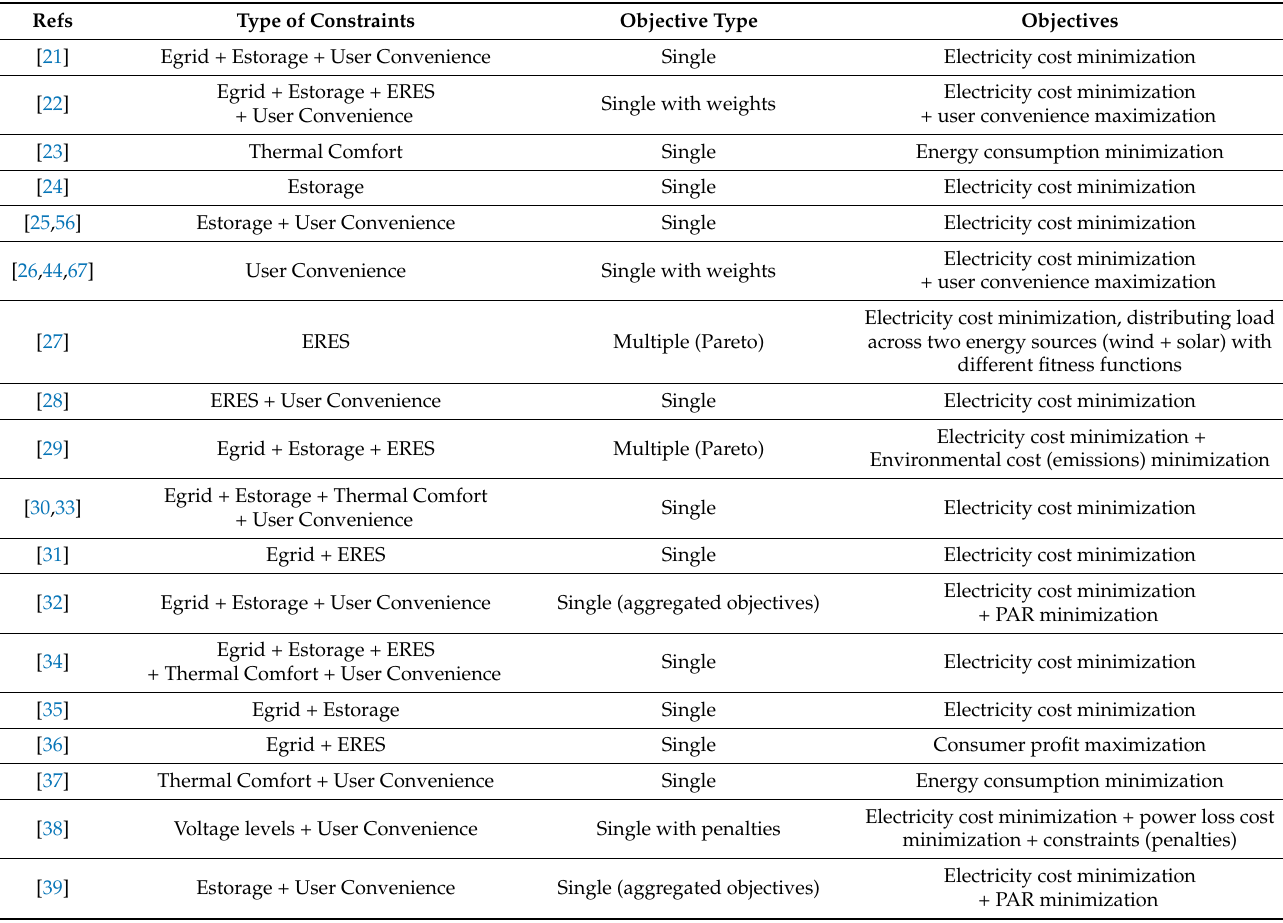
Table 2. Taxonomy of the reviewed works based on the optimization